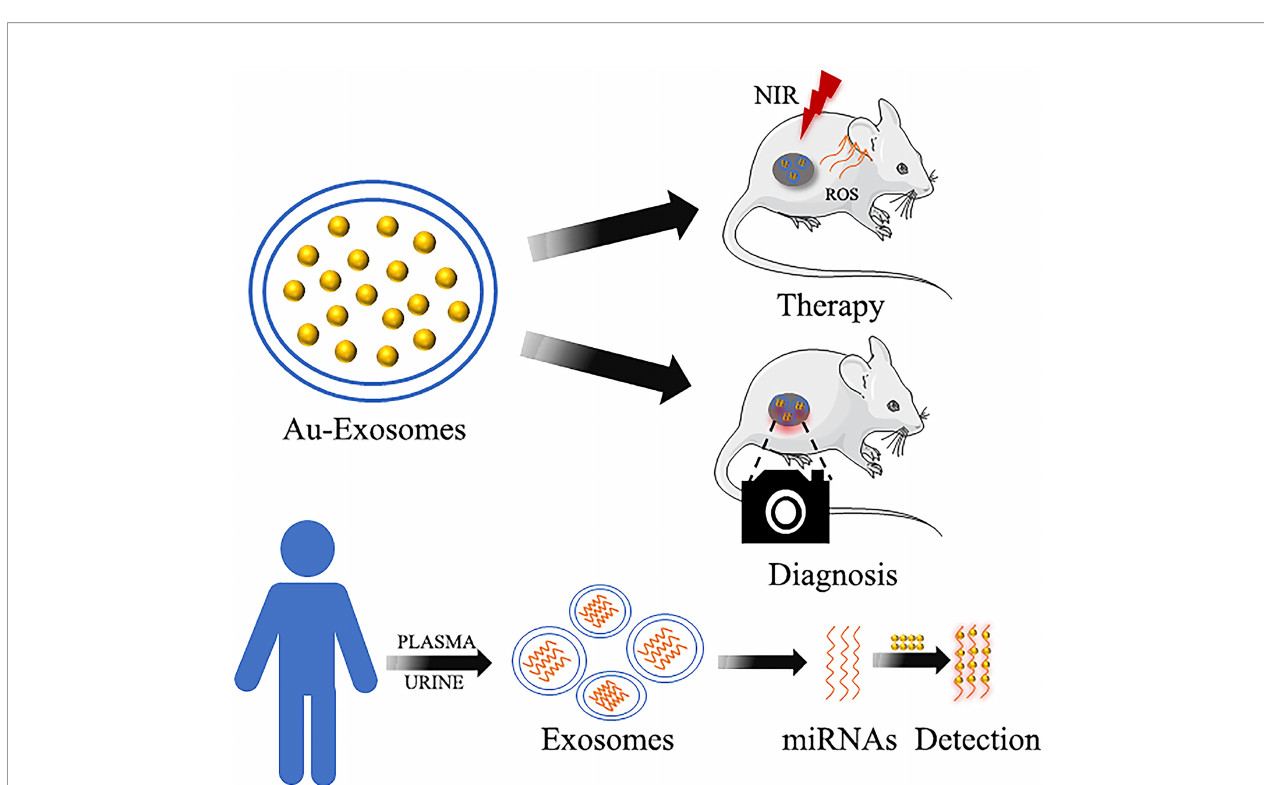
FIGURE 5 | Gold nanoparticles combined with exosomes in cancer therapy and